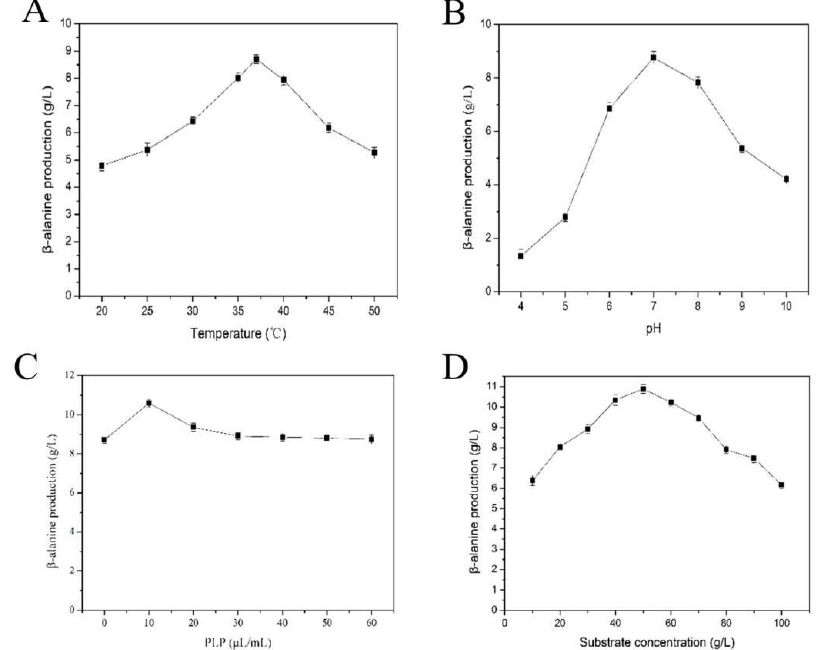
Figure 7. Optimization of the whole-cell biocatalysis conditions. ( A ), The e ff ect of reaction temperature on β -alanine production; ( B ), The e ff ect of reaction pH on β -alanine production; ( C ), The e ff ect of PLP addition on β -alanine production; and, ( D ), The e ff ect of substrate concentration on β -alanine production.